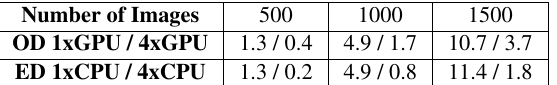
Table 1. Comparison of the image similarity estimation runtime in minutes using the original and the embedded descriptors. The original real descriptors (OD) were matched using GPU (Wu, 2007) and the embedded binary descriptors (ED) using CPU with one and four GPUs/CPU cores.